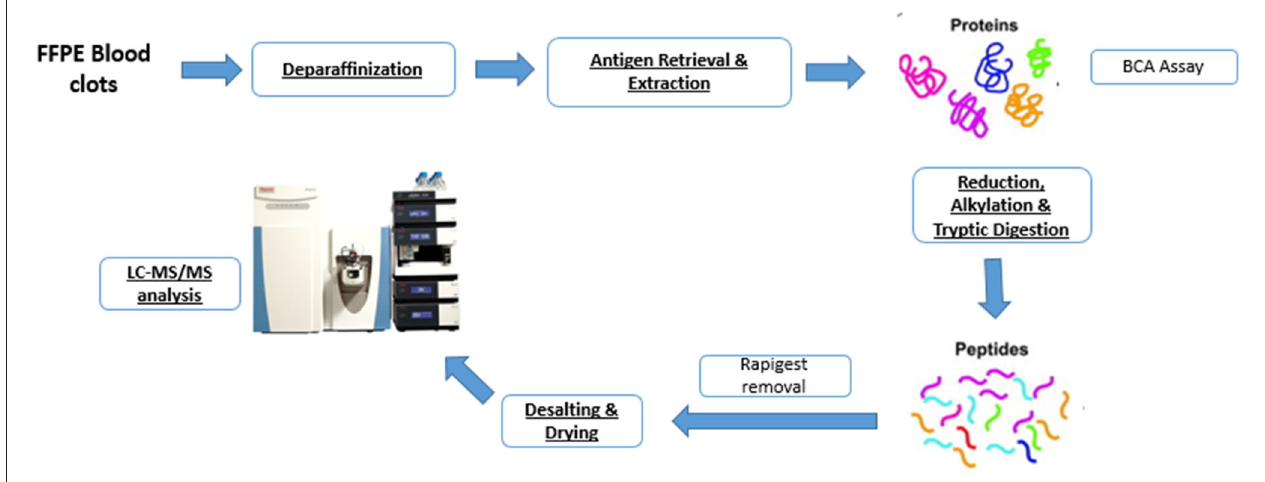
FIGURE 1 | Shotgun proteomics workflow for characterizing the protein content of formalin-fixed paraffin-embedded (FFPE) blood